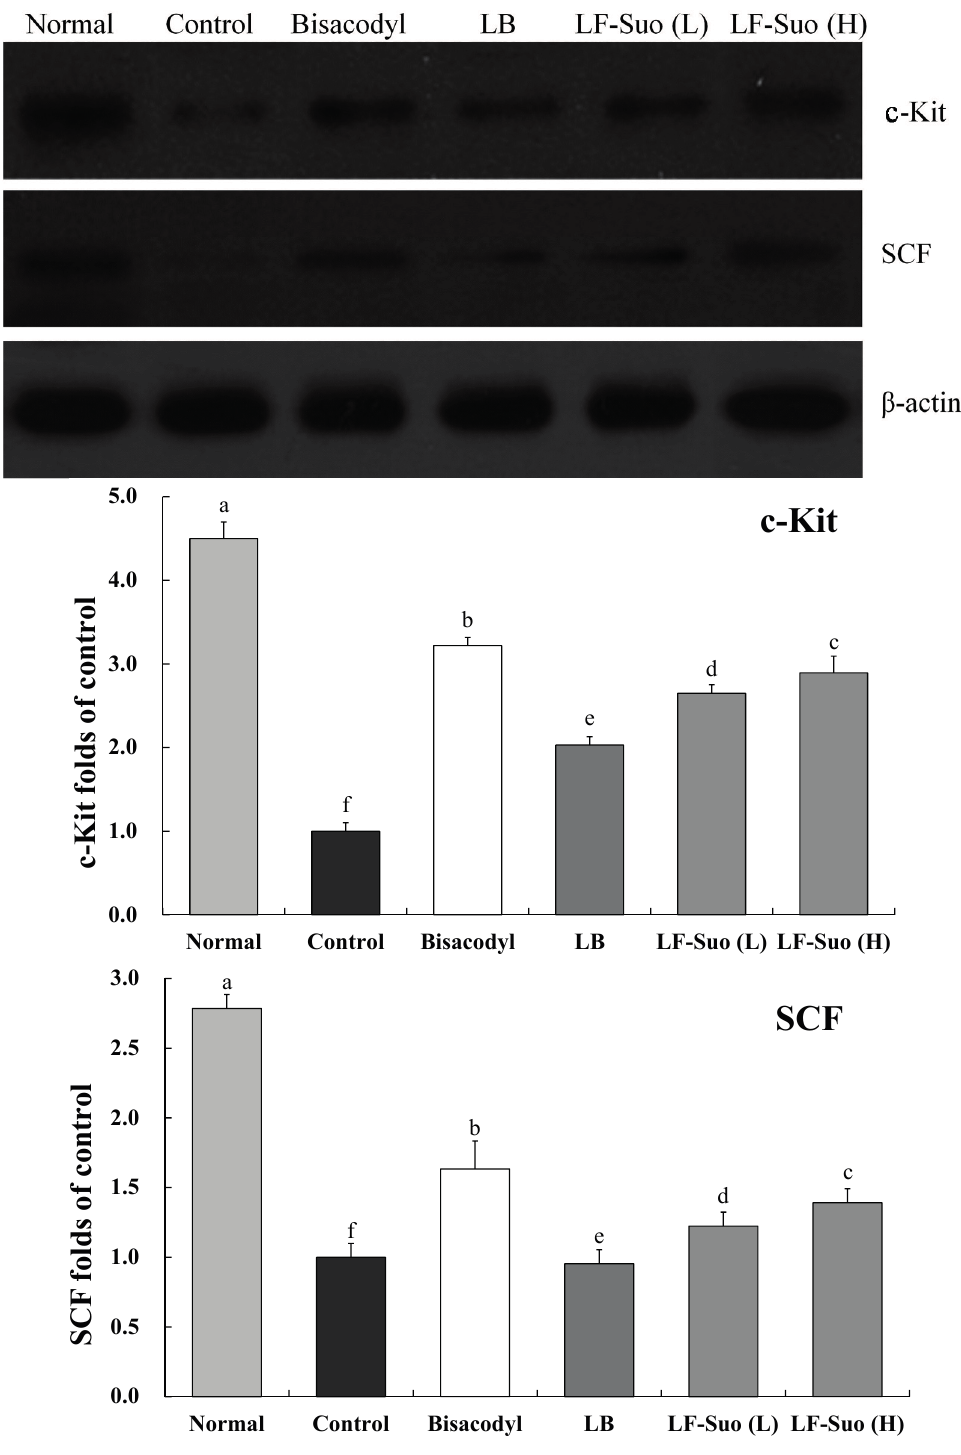
Figure 5. Effects of Lactobacillus fermentum Suo on the protein expression of c-Kit and SCF in the small intestine. n = 10 ICR mice in each group, bisacodyl: 100 mg/kg b.w.; LB: Lactobacillus bulgaricus (1.0 × 10 9 CFU/kg b.w.); LF-Suo (L): Lactobacillus fermentum Suo (0.1 × 10 9 CFU/kg b.w.); LF-Suo (H): Lactobacillus fermentum Suo (1.0 × 10 9 CFU/kg b.w.); a–f Mean values with different letters over the bars are significantly different ( p < 0.05) according to Duncan’s multiple range